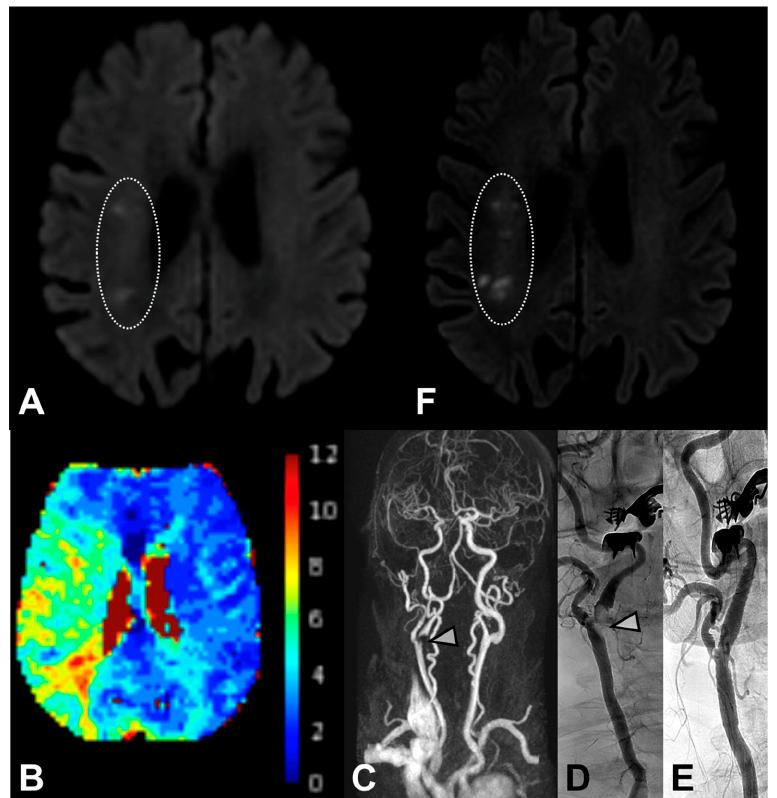
Figure A1. Example of new punctiform ischemic DWI-MRI lesions for a patient with fluctuant left-sided hemiparesis. Initial MRI (5 h from onset) did not find any intracranial large vessel occlusion, but DWI-MRI depicted punctiform ischemic lesions in the right anterior junctional area. ( A ) Perfusion MRI showed a large right sylvian hypoperfusion (TMax > 6 s). ( B ) MR-angiography of supra-aortic arteries objectified a severe proximal ICA stenosis ( C ; white arrow) confirmed by DSA performed (130 h after onset) before ( D ; white arrow) a successful carotid artery stenting ( E ). DWI-MRI performed 24 h after CAS objectified new silent punctiform DWI-MRI lesions in the same right anterior junctional area ( F